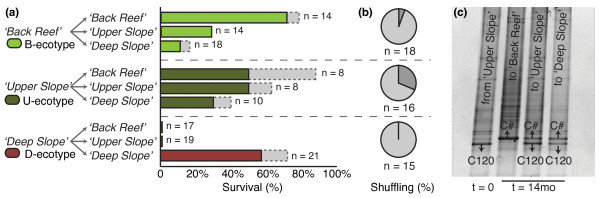
Survival and symbiont shuffling of transplanted fragments. (a) Survival rates one year after transplantation. Coloured bars refer to healthy fragments, whereas the grey fraction refers to transplanted fragments that still had some living tissue, but were mostly dead. Sample sizes (n) refer to the total number of fragments (alive or dead) present on the rack after 14 months (missing fragments were excluded). (b) Incidence of symbiont shuffling (i.e., change in the abundance of already present Symbiodinium). Dark grey indicates shuffling, whereas light grey indicates no change in symbiont community. Note that in none of the corals, new Symbiodinium types were acquired (i.e., symbiont "switching"). (c) Example of changes in Symbiodinium profile for a transplanted colony originating from the 'Upper Slope' habitat.